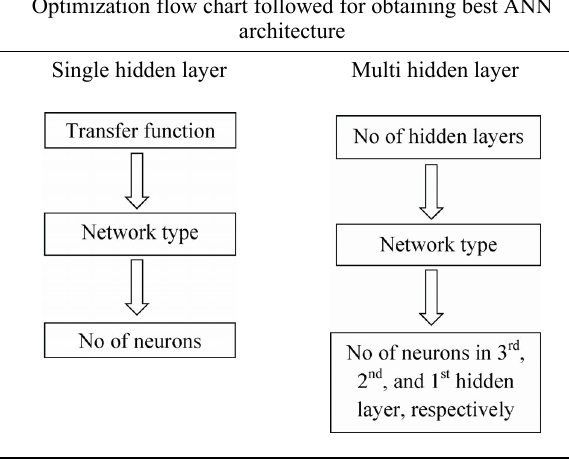
Table 15 Optimization flow